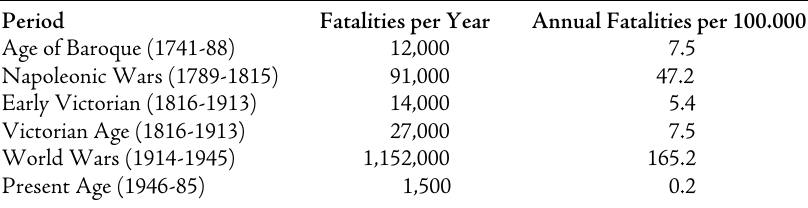
Table 2 – Fatalities in normal and crisis